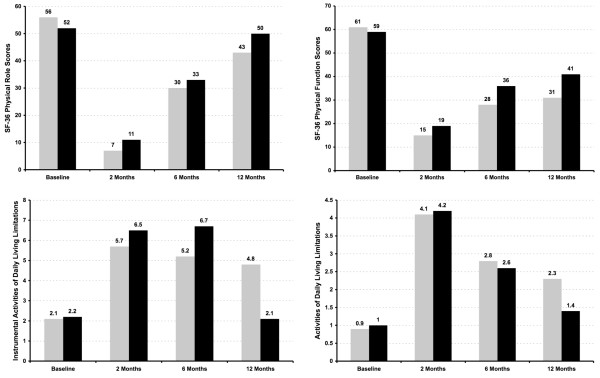
Quality of life and functional status over time for PMV patients. The gray bars represent PMV patients ventilated for ≥ 96 hours with a tracheostomy (DRG 541/542), and the black bars represent PMV patients ventilated for ≥ 21 days. Mean values are shown above the bars corresponding to scores on the SF-36 physical function and physical role scores as well as for limitations in both instrumental (IADLs) and basic (ADLs) activities of daily living. Because of the overlap of 88 persons in these two PMV groups, group-based statistical tests were not performed. ADL, activity of daily living; DRG, diagnosis related group; IADL, instrumental activity of daily living; PMV, prolonged mechanical ventilation; SF-36, Short Form 36-item questionnaire.